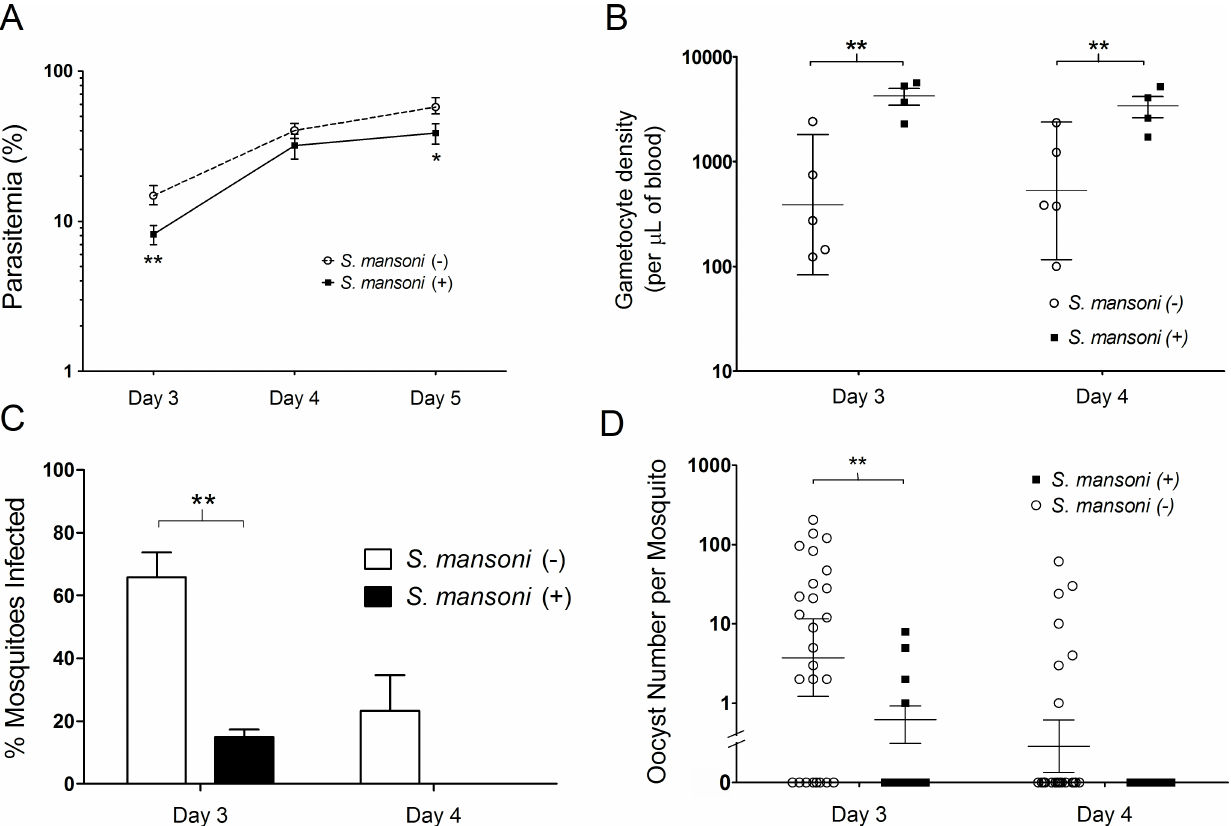
Fig 7. Gametocyte infectivity. (A) Parasitemia. Female BALB/c mice were each inoculated with 1 x 10 6 Plasmodium yoelii parasitized erythrocytes intravenously with (n = 4 mice) or without (n = 5) pre-existing Schistosoma mansoni infection. Parasitaemia was determined by microscopic examination on days 3, 4, and 5 post-inoculation; day 3: Student’s two-tailed t-test; (cid:3)(cid:3) P < 0.01, t = -4.906, df = 7; Day5: (cid:3) P < 0.05, t = -2.922, df = 5 ( B ) Gametocyte density. Gametocyte density was determined on days 3 and 4 post-inoculation of 1 x 10 6 P . yoelii -parasitized erythrocytes intravenously. Day 3: Student’s two-tailed t-test; (cid:3)(cid:3) P < 0.01, t = 3.813, df = 5; Day 4: (cid:3)(cid:3) P < 0.01, t = 3.608, df = 5. Error bars show the geometric mean with 95% confidence intervals. (C) Percentage of mosquitoes with one or more oocysts present on the midgut eight days post-feeding on infected mice. A minimum of eight mosquitoes were allowed to feed on each individual mouse in the group per day (cid:3)(cid:3) P = 0.0003, (2-way ANOVA, F = 22.23, DFn = 1, DFd = 14). Error bars mar the standard error of the mean per mouse group. (D) Oocyst numbers per mosquito. The numbers of oocysts present on mosquito midguts were determined eight days post-mosquito feeding; day 3: Student’s two-tailed t-test, (cid:3)(cid:3) P < 0.01, t = 3.077, df = 25. Error bars show the geometric mean with 95% confidence intervals. Data is representative of three independent